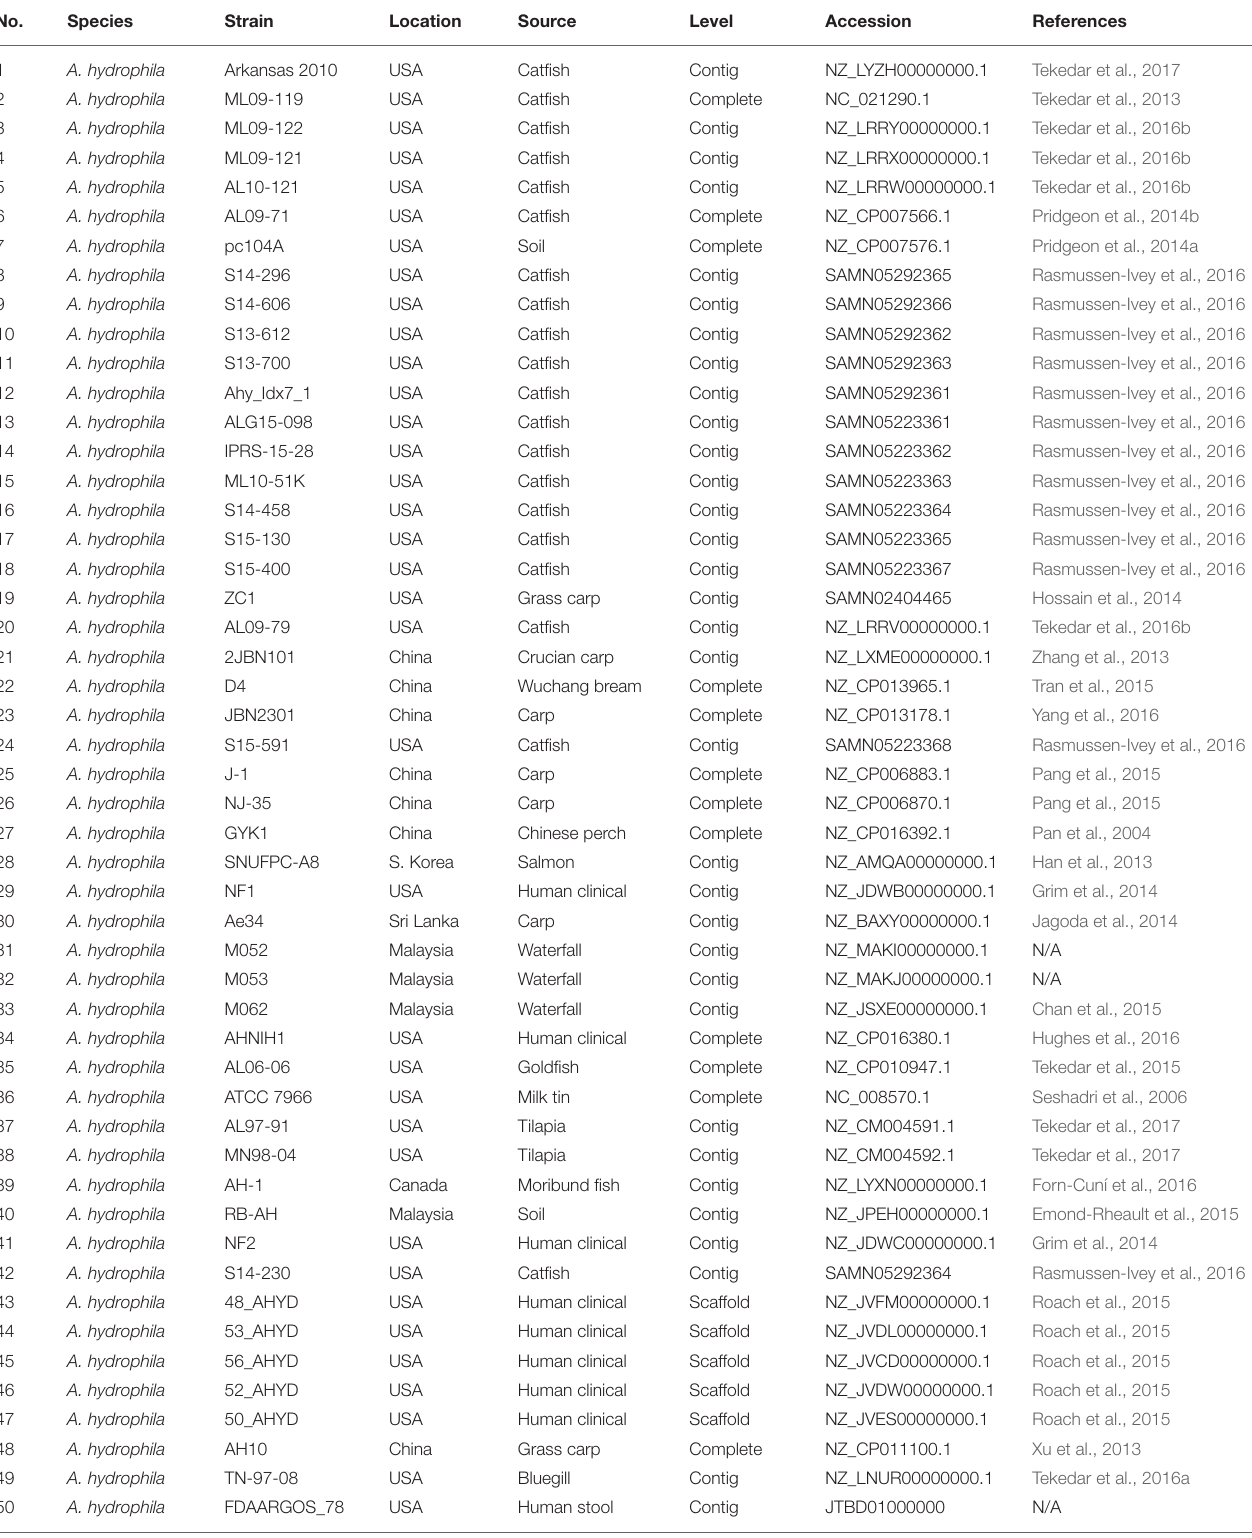
TABLE 1 | A. hydrophila genomes used in comparative genomic analyses.